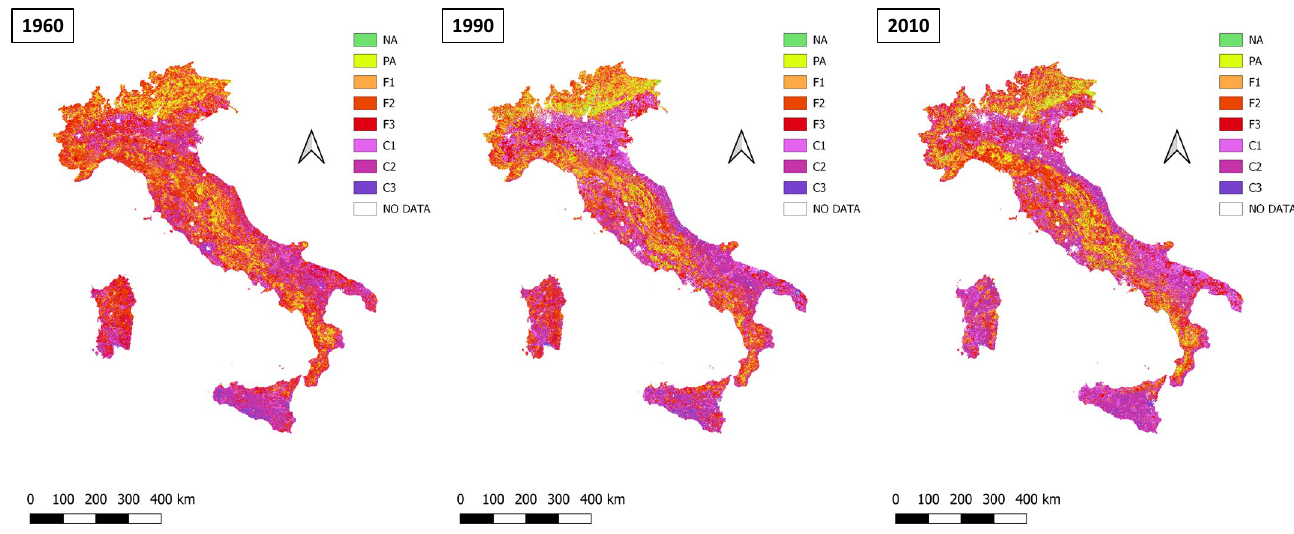
Figure 3. Classification of the Italian land according to the eight vulnerability classes for the years 1960, 1990, and 2010. Table 2. Spatial partition of land vulnerability macro-classes by year.